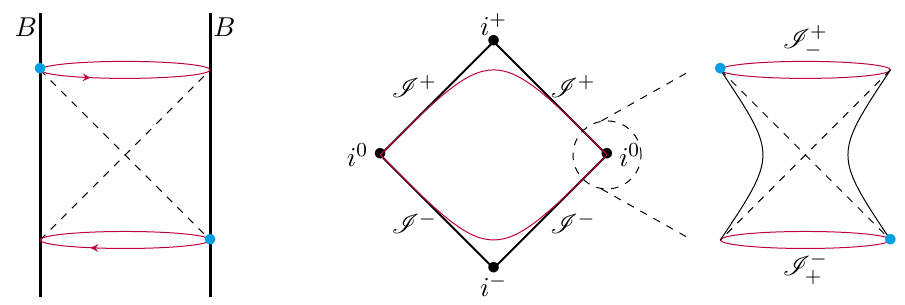
Figure 3 . Antipodal matching in (cid:13)at and AdS spaces. As depicted in middle and right (cid:12)gures, in Minkowski space the spatial in(cid:12)nity can be represented by a de Sitter space. Antipodal map is a map from past to future boundary of the dS space. The left (cid:12)gure shows AdS space in dS slicing where the blue points are mapped onto each other under antipodal map. The antipodal matching condition is the boundary condition that maps the state/con(cid:12)gurations to their CPT conjugate on dS